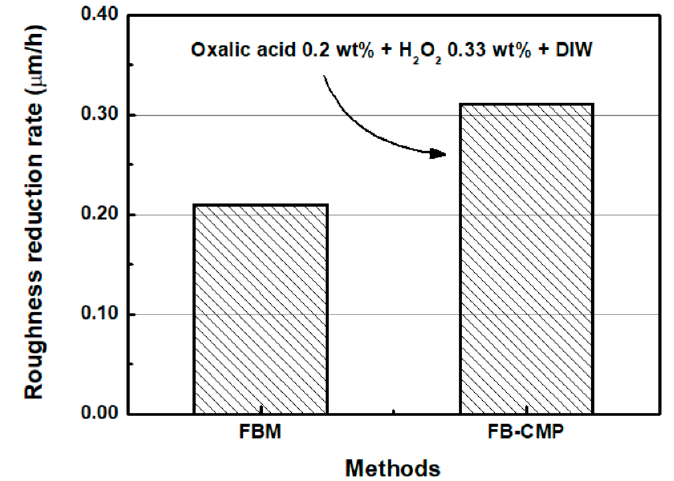
Figure 15. Roughness reduction rates of FBM and FB-CMP (H 2 O 2 concentration: 0.33 wt %, and oxalic acid concentration: 0.2 wt %).